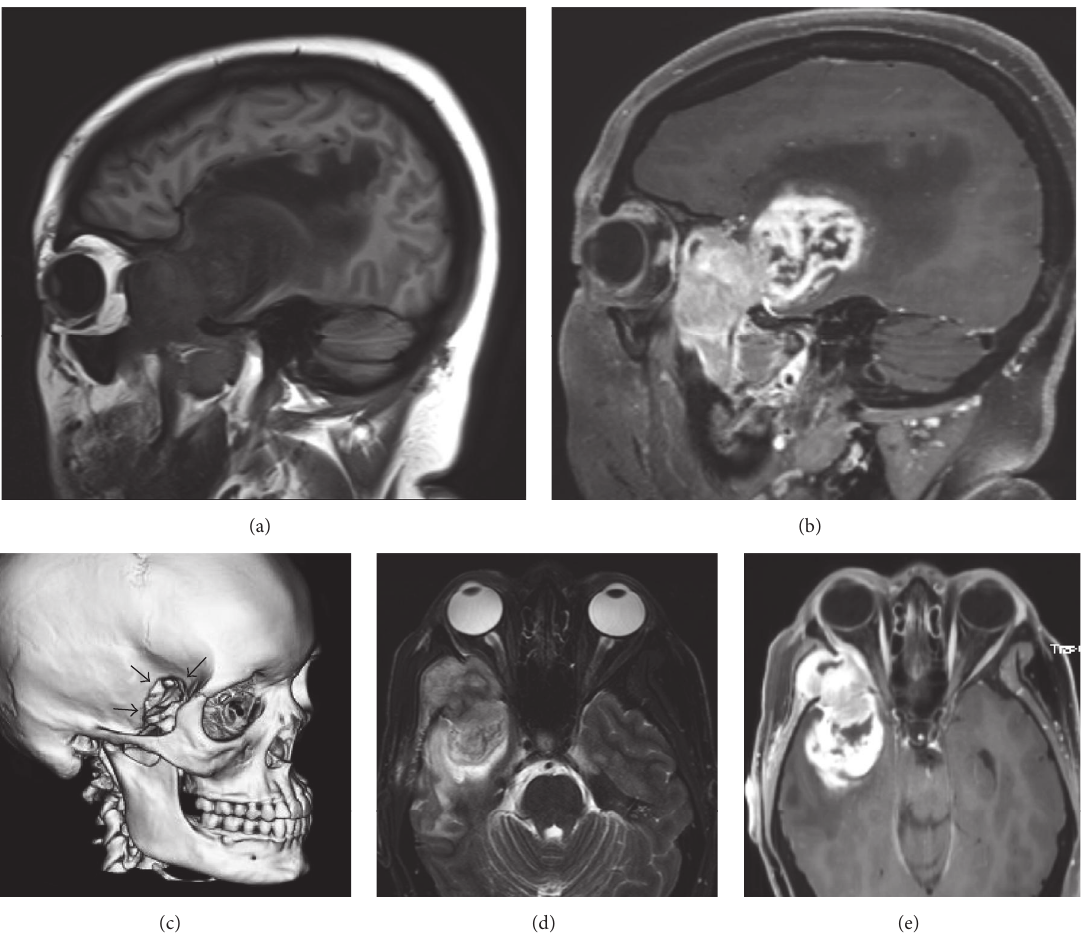
Figure 1: MRI and CT findings prior to surgery. (a) Sagittal T1-weighted imaging (T1WI) demonstrated a heterogeneous T1 hypointense mass involving a majority of the anterior temporal lobe with associated mass effect and surrounding vasogenic edema. Tumor extends through the greater wing of the sphenoid into the infratemporal fossa. (b) Sagittal postgadolinium T1WI demonstrates avid heterogeneous enhancement. The anterior portion in the soft tissues solidly enhances and intracranially has central necrosis. (c) 3D reconstruction from head CT demonstrates aggressive destruction of the greater wing of the sphenoid. (d) Axial FSE T2-weighted imaging demonstrates the mass to be heterogeneous iso/hypointense tumor with surrounding vasogenic edema suggesting increasing cellularity. (e) Axial postgadolinium T1WI demonstrates avid heterogeneous enhancement with central necrosis